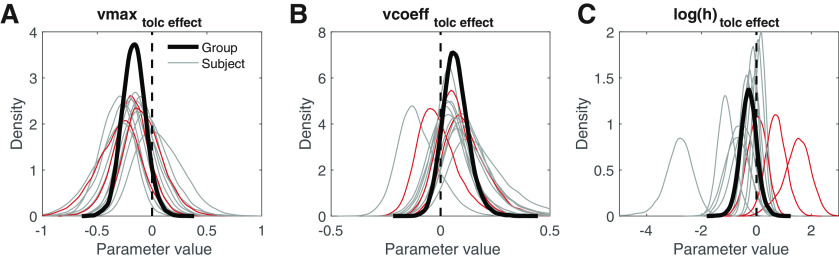
Posterior group means (solid black lines) and individual subject posterior distributions (gray: Val/Val and Val/Met; red: Met/Met) for the tolcapone-induced changes in maximum drift rate (A), in value-dependent drift rate modulation (B), and in the probability discount rate (C). The mean change in vmax was <0 in 13/14 subjects. In vcoeff, it was >0 in 12/14 subjects, and in log(h), it was <0 in 9/14 subjects.